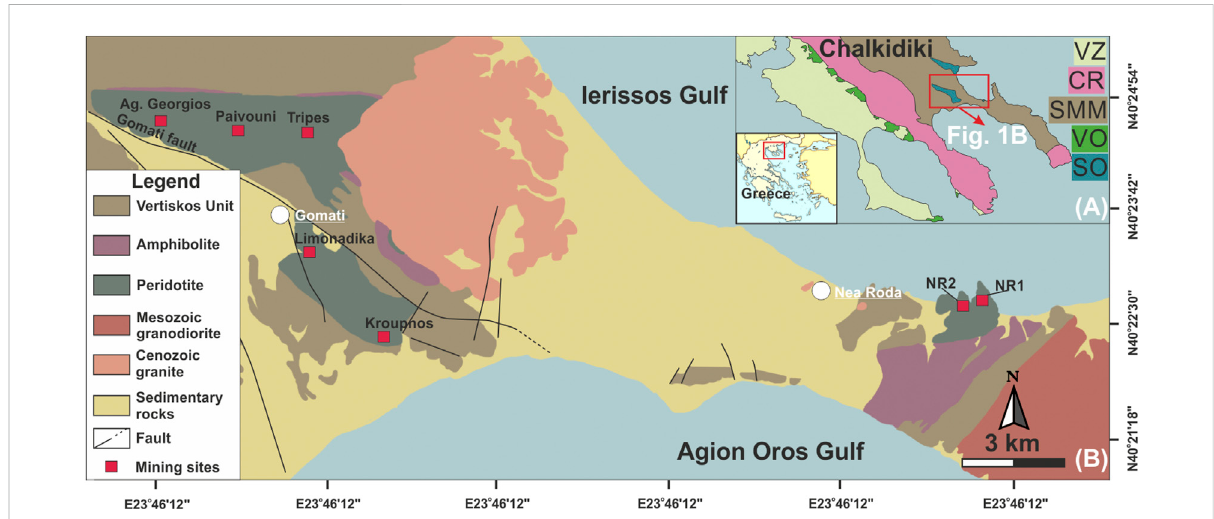
FIGURE 1 (A) Innermost Vardar ophiolites (VO) situated at the contact of the Vardar Zone (VZ), the Circum Rhodope belt (CR) and the Serbomacedonian Massif (SMM) hosted ma fi c-ultrama fi c magmatic suites (SO). (B) Simpli fi ed geological map of the studied ultrama fi c bodies, namely Gomati and Nea Roda (NR), modi fi ed after the Ierissos sheet of the Hellenic Survey of Geology and Mineral Exploration (HSGME). White circles represent the Gomati and Nea Roda